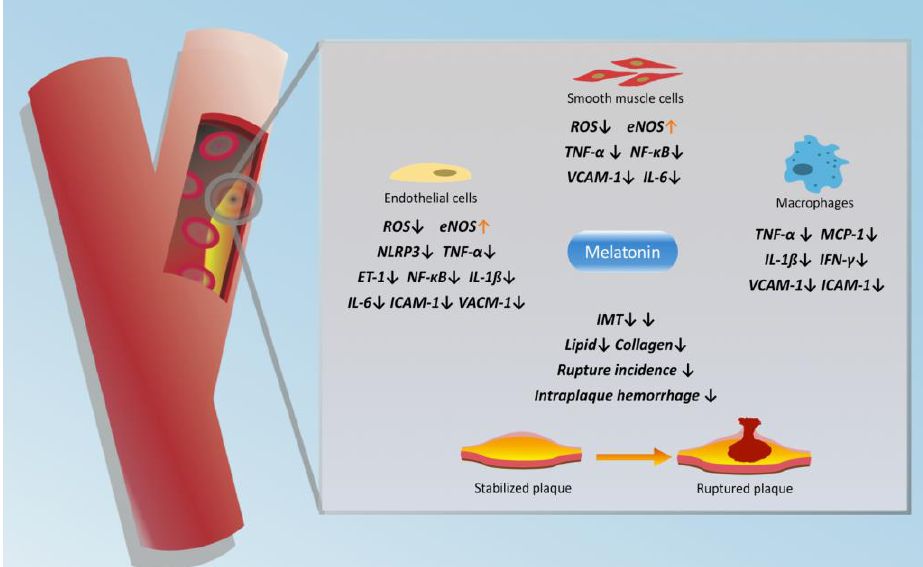
Figure 1. The potential atheroprotective effects of melatonin in attenuating the progression of CAS. eNOS, endothelial nitric oxide synthase. ET-1, endothelin-1. ICAM-1, intercellular adhesion molecule-1. IFN-γ, interferon-γ. IL-1β, interleukin-1β. IL-6, interleukin-6. IMT, intima-media thickness. MCP-1, monocyte chemoattractant protein-1. NLRP3, NOD-like receptor family pyrin domain-containing 3. ROS, reactive oxygen species. VCAM-1, vascular cell adhesion molecule 1.